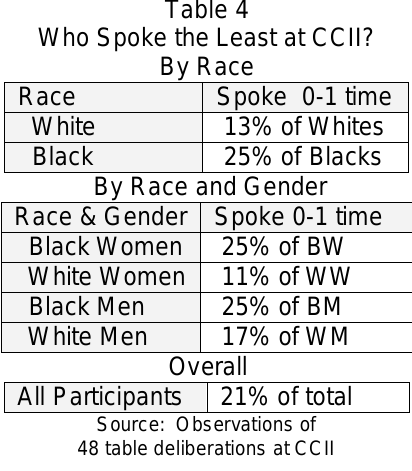
Black Participation Rates by Proportion of Blacks at the Table Proportion of Blacks at the Table LOW